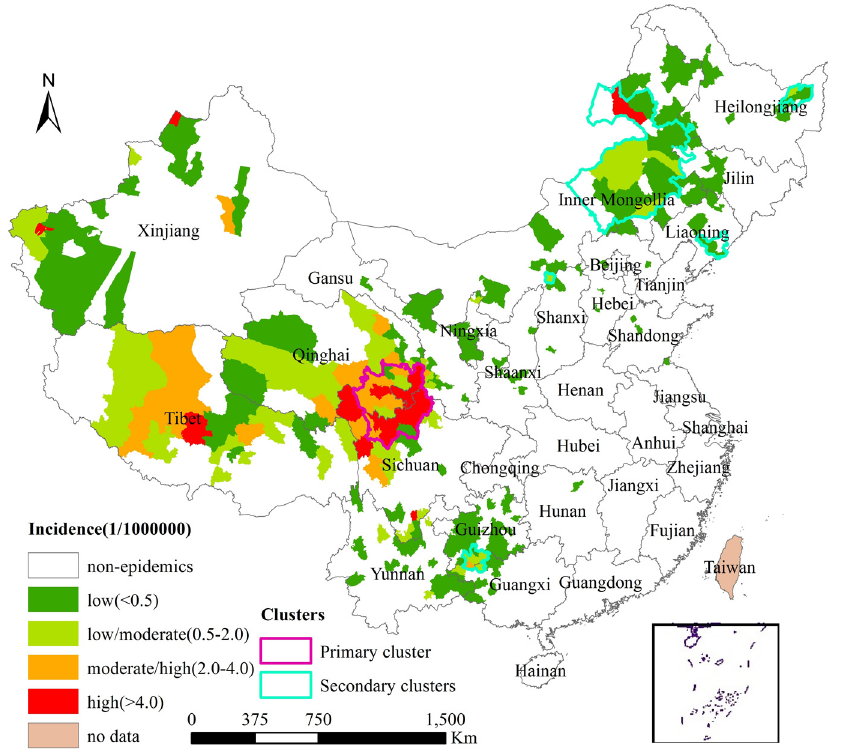
Fig 3. Spatiotemporal clusters of human cutaneous anthrax in mainland China, 2005 – 2012.